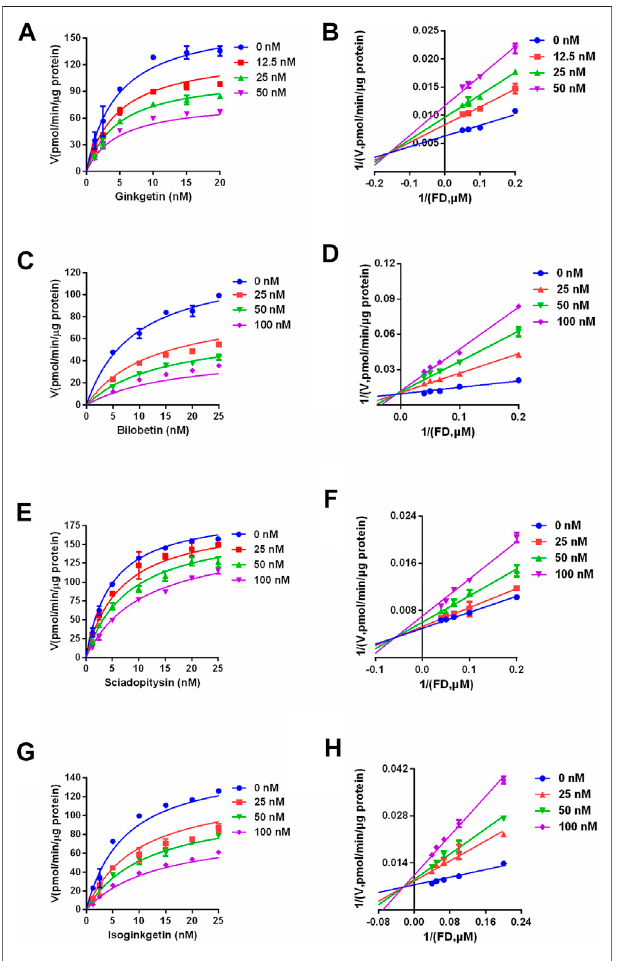
FIGURE8| Theinhibitionkineticand Lineweaver-Burk plotsofginkgetin (A,B) , bilobetin (C,D) , sciadopitysin (E,F) and isoginkgetin (G,H) against CES2-catalyzed FDhydrolysisinHLMs. All datawereshown as mean ± SDof triplicate assays.